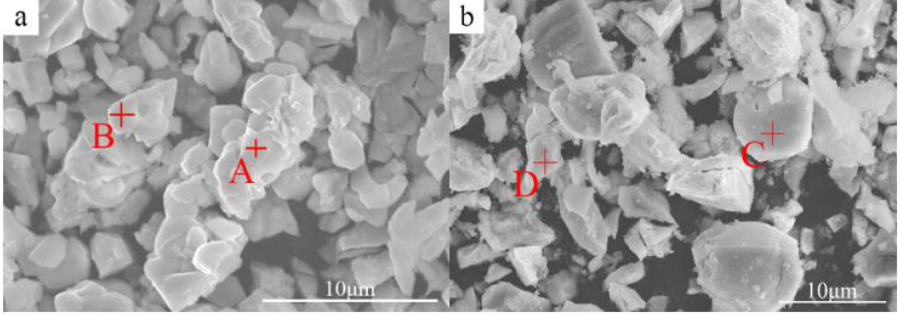
Figure 3. The morphologies of the secondary phases separated from experiment alloy: ( a ) ZCIII, ( b ) ZCVI. Table 2. EDS Analysis Results of Typical Alloy Solid Phase Separation. Composition (at.%) Mark Position Zn